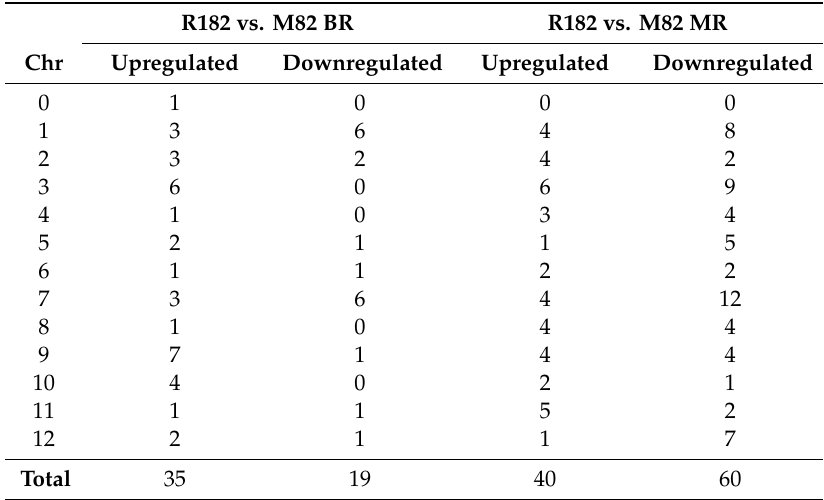
Figure 1. Volcano plots of genes di ff erentially expressed between R182 and M82 at ( A ) breaker and ( B ) mature red fruit stages. The y-axis corresponds to the mean expression value of log 10 (false discovery rate, FDR) and the x-axis displays the log2 (fold change) value. The red dots represent the significantly upregulated genes while the green dots represent the significantly downregulated genes. Grey dots represent the genes whose expression levels did not reach statistical significance. Table 1. Number of upregulated and downregulated genes between R182 and M82 at breaker (BR) and mature red (MR) stages. The distribution of the di ff erentially expressed genes across the tomato chromosomes (Chr) is reported.